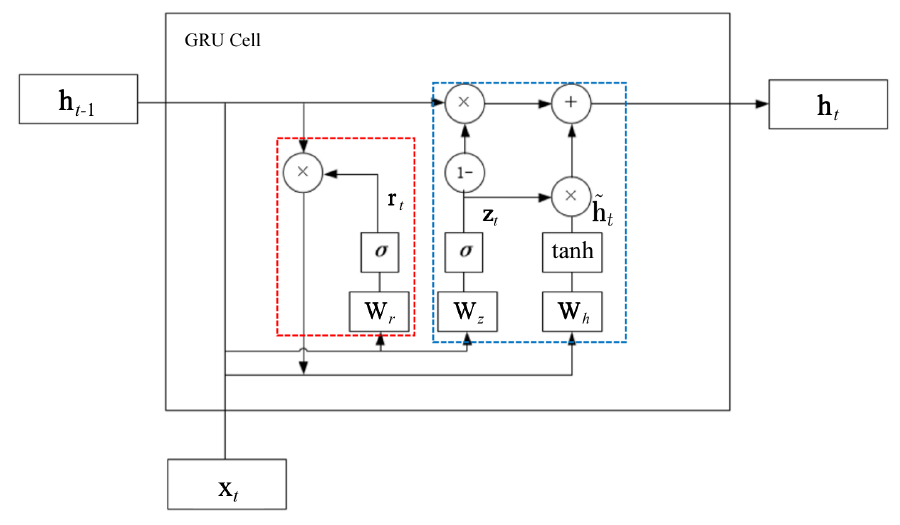
Figure 2. Structure diagram of Gated Recurrent Unit (GRU)